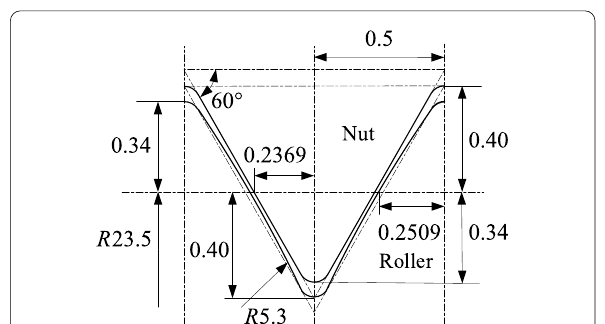
Figure 13 Cross-sectional view of the roller-nut engagement